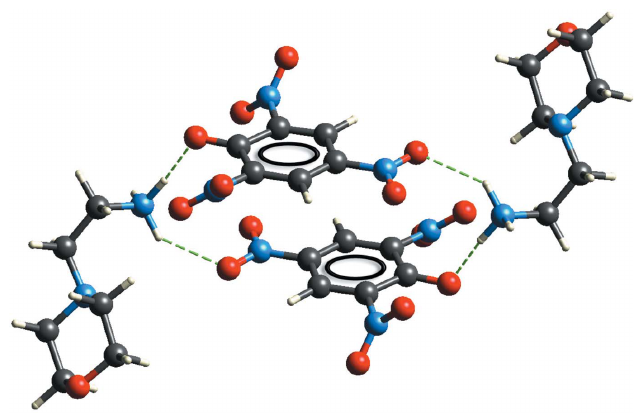
Figure 5 R 4 (20) ring motif formed between two ammonium group and two picrate 4 anions and (cid:2) – (cid:2) stacking interactions.